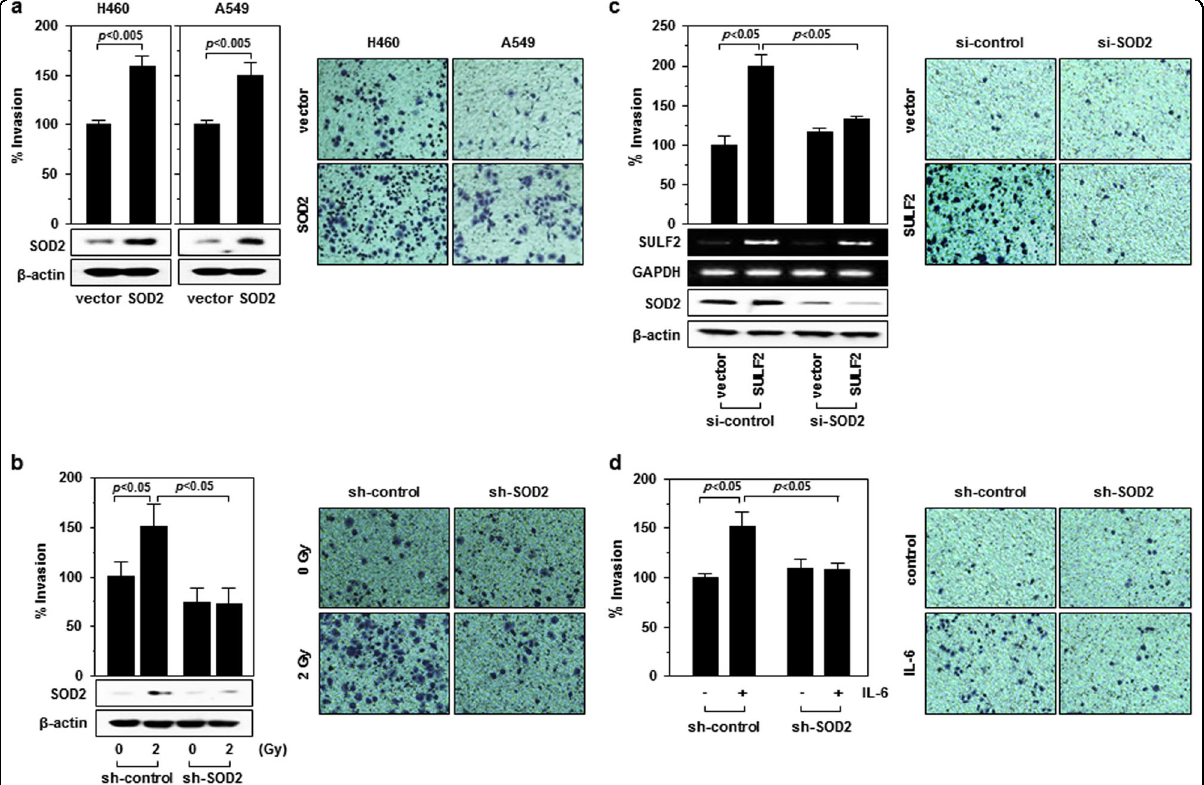
Fig. 2 SOD2 mediates IR-induced cell invasion. a H460 and A549 cells were transfected with control (empty vector) or SOD2 expression vector. After 48 h of incubation, a cell invasion assay was performed. Cells that invaded through Matrigel-coated polycarbonate fi lters were imaged, and the number of invaded cells was counted and plotted. SOD protein levels were compared by western blot analysis. b H460 cells infected with lentiviruses expressing a control or SOD2-targeting shRNA were irradiated, and invasiveness and protein levels were then analyzed 48 h after irradiation. c H460 cells were cotransfected with a SULF2 expression vector and SOD2 siRNA as per the indicated combinations, and cell invasiveness was then assessed. d H460 cells infected with lentiviruses expressing control RNA or SOD2-speci fi c shRNA were incubated in the presence or absence of IL-6 (100ng/mL) for 24 h. Cell invasiveness was then